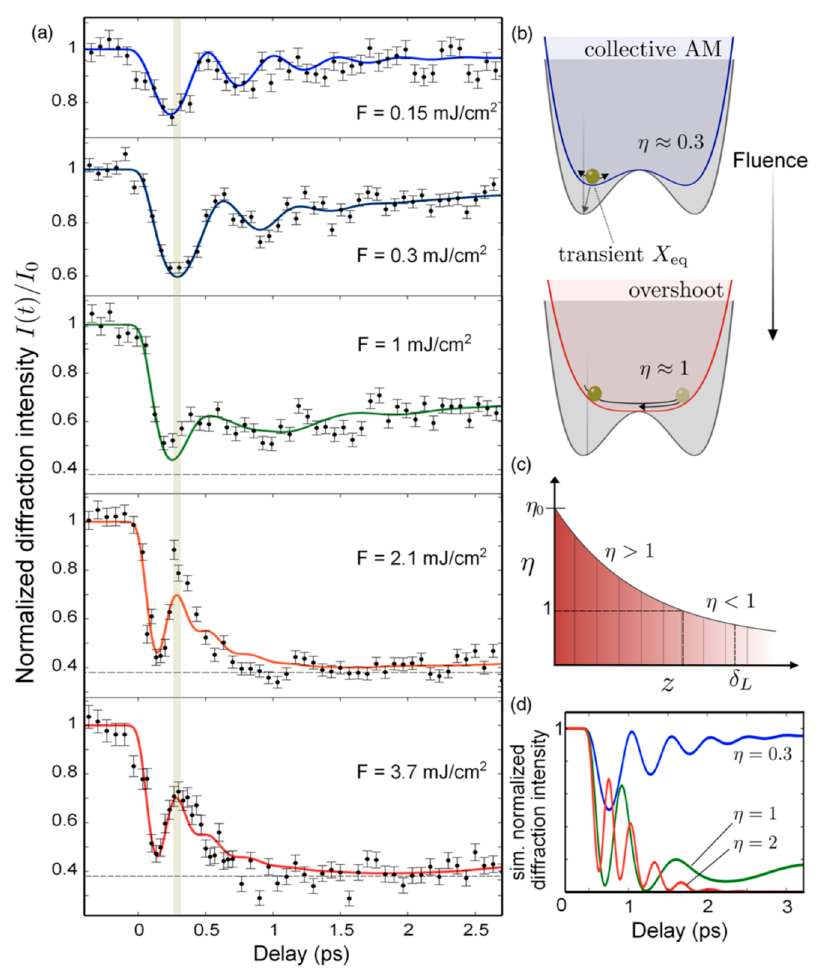
Figure 2. Results from FEMTO line (laser slicing) at the Swiss Light Source (SLS). ( a ) Time evolution of the normalized SL diffraction peak intensity at different excitation fluences (F). The horizontal dashed line in the higher fluence scan represents saturation background. Solid lines in red are fits obtained by implementing an equation of motion derived from a double-well potential that includes a phenomenological damping term. They grey vertical line denotes the time at which the SL diffraction intensity recovers and peaks, t = 0.35 ps. ( b ) Double-well potential; the grey potential corresponds to the unperturbed charge-density wave (CDW) state ( η = 0). Note that η is a scaled excitation parameter proportional to F so that η = 1 corresponds to the threshold value for overshooting, i.e., where the double-well shape of the potential vanishes (red curve). The green circle represents the collective atomic displacement of the SL distortion or dimmers along the structural coordinate of the Peierls distortion. The transient quasi-equilibrium position after excitation is labeled X eq . ( c ) Schematic of the inhomogeneously excited crystal in the case of a high fluence excitation that leads to η 0 > 1, the z axis corresponds to the axis perpendicular to the surface plane; δ L corresponds to the laser penetration depth. ( d ) Simulated diffraction signals of a thin layer for certain values of η . Reproduced from Reference [20] with permission from the American Physical Society (APS).